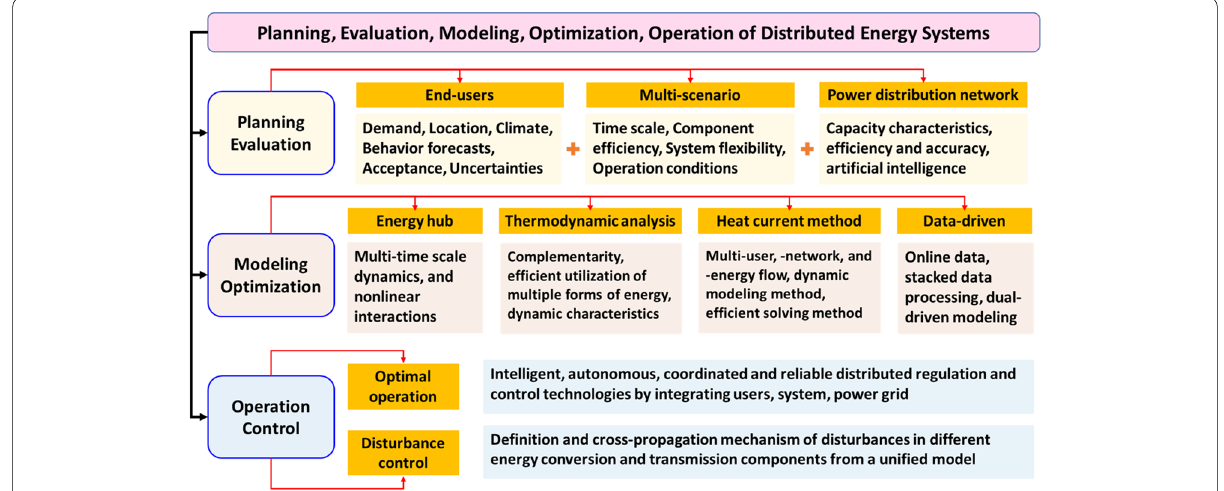
Fig. 11 Research focus on different approaches in distributed energy